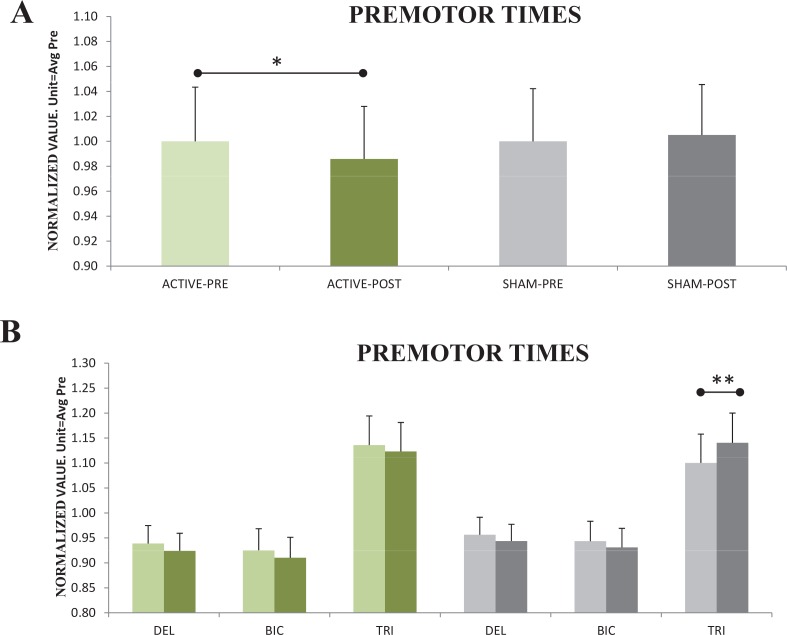
(A) PMT at Post were differently modulated by Sham-tDCS compared to the other two active protocols, which did not differ each other (shown pooled in green tones). There was a significant decrease at Post after both active protocols. (B) Sham stimulation increased Post PMT, specifically in the triceps muscle. The y-axis unit indicates the mean response across all subjects and conditions at Pre. *p<0.05; **p<0.01.